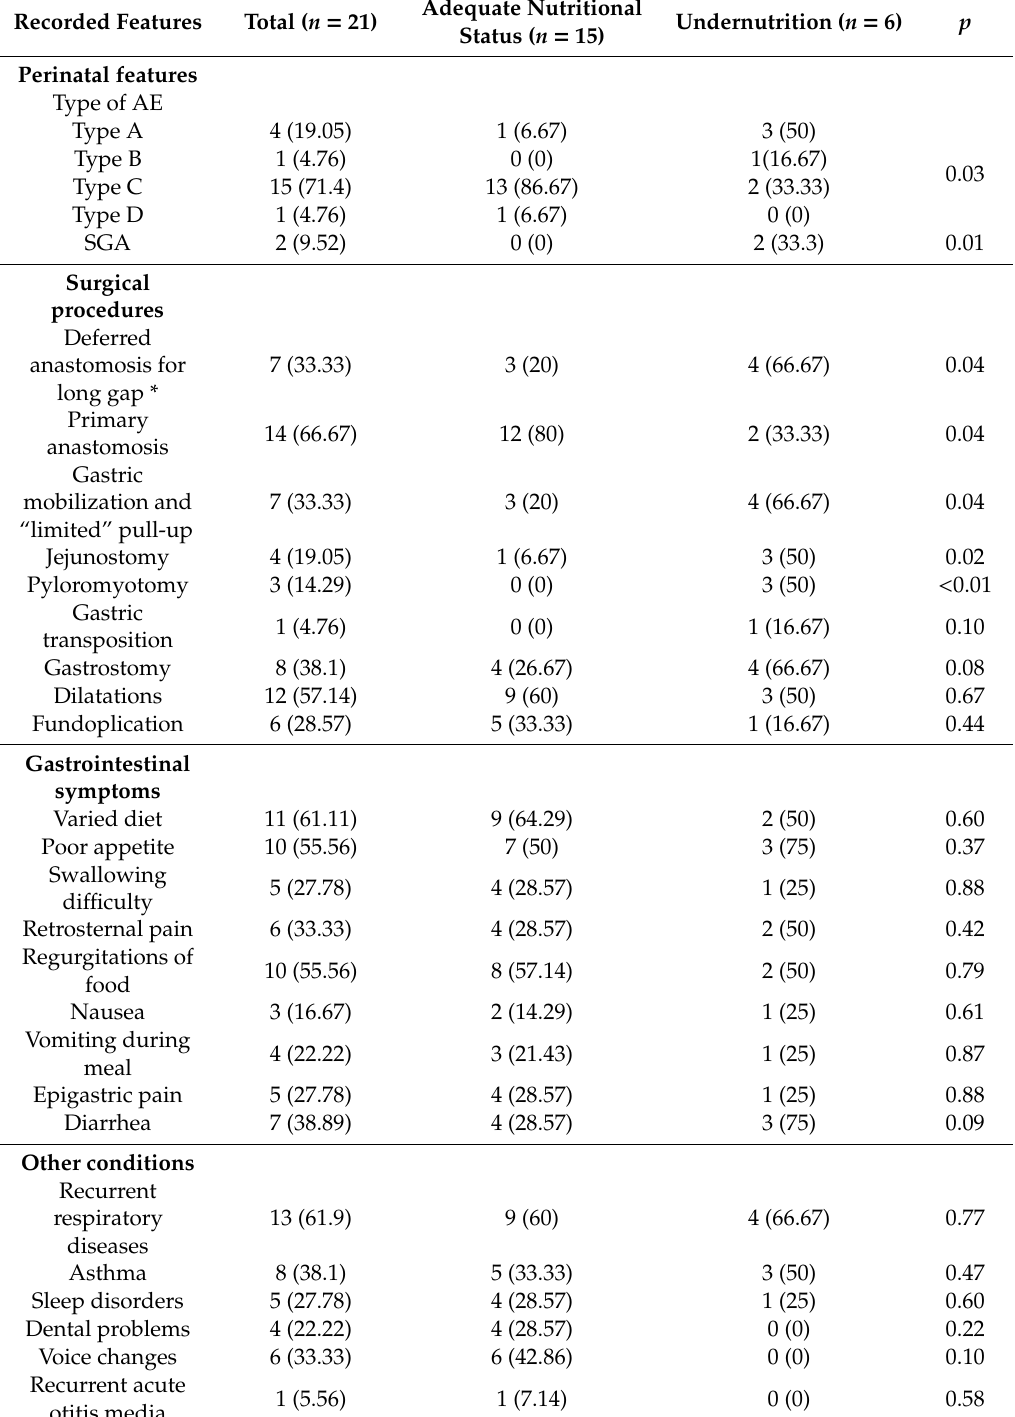
Table 2. Risk factors for